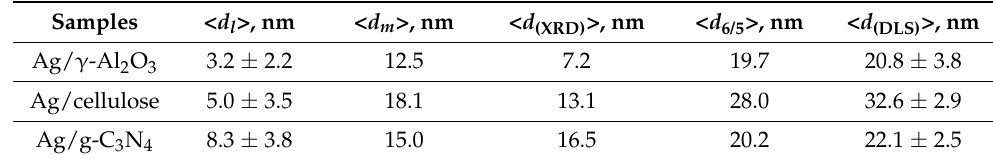
Table 1. TEM and XRD data for supported silver nanoparticles and DLS data for silver-contained sols, which are prepared by the STS technique from supported silver catalysts.